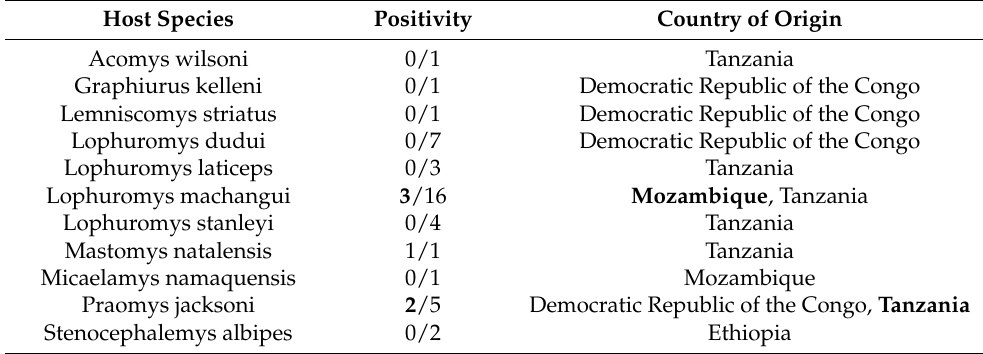
Table 1. Animals screened by Illumina sequencing.